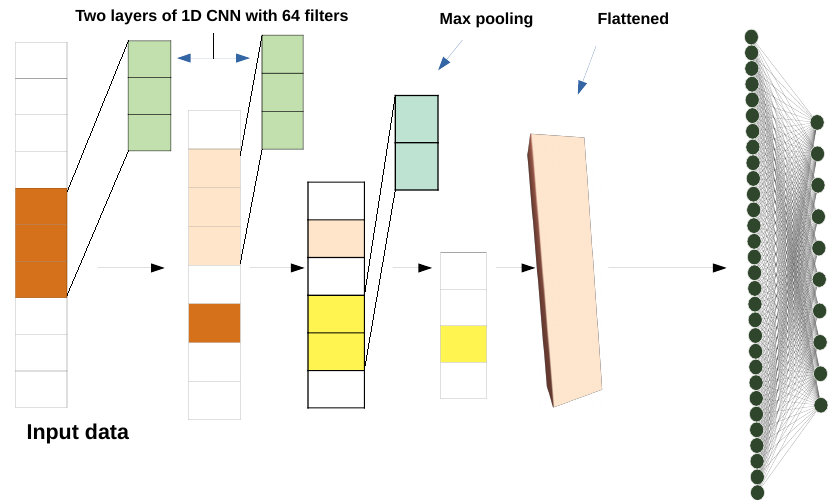
Figure 3. Architecture of the one dimensional convolutional neural networks (1D CNN) model for human activity